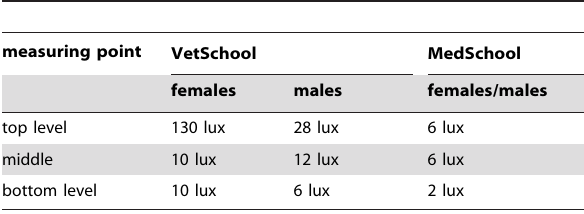
Table 2. Light intensities inside cages measured at 3 levels of the